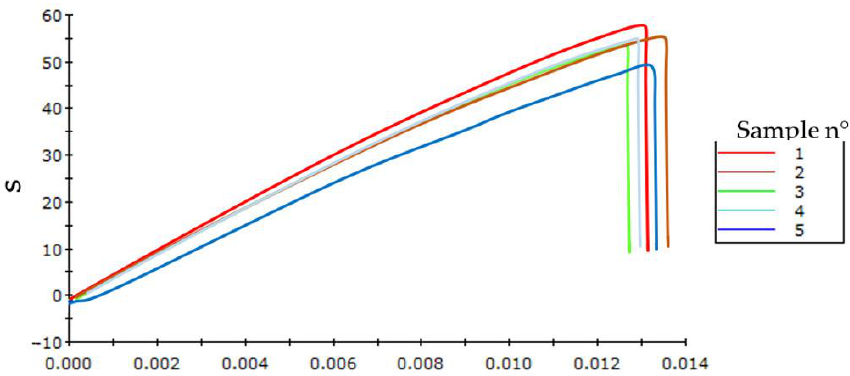
Figure 10. Tensile curves obtained for 5 sorted fibers specimens with a fiber orientation of 0° and for a test performed at a speed of 1 mm/min.